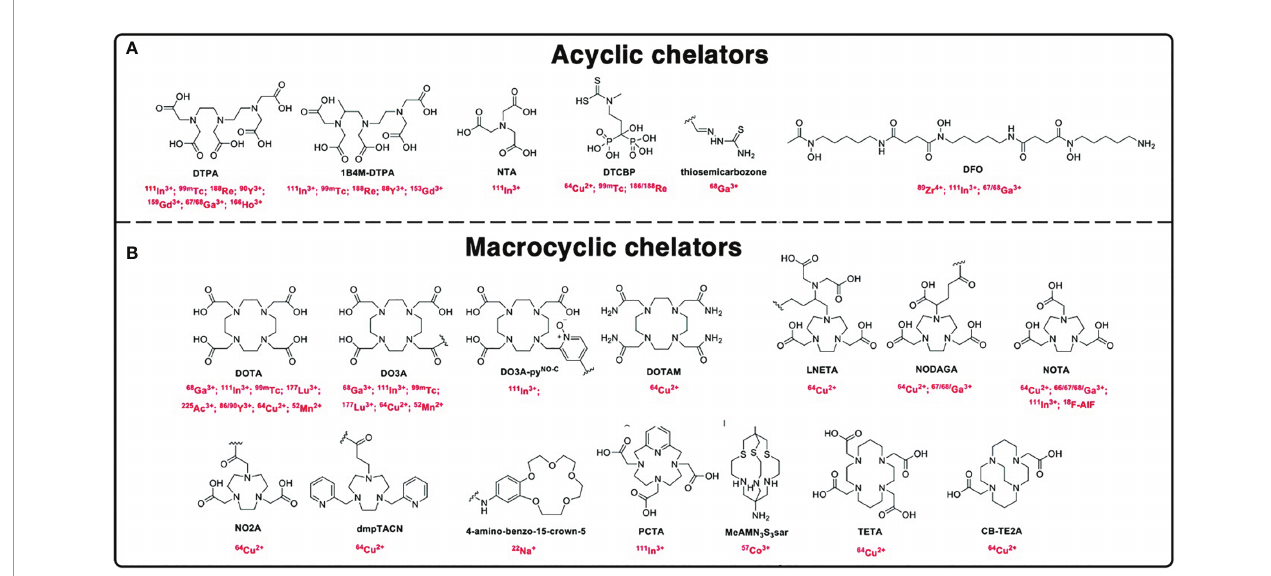
FIGURE 2 | Chemical structures of the chelators. (A) Acyclic chelators and (B) macrocyclic chelators and their respective radionuclides used for radiolabeling nanomaterials [adapted from Pellico et al.